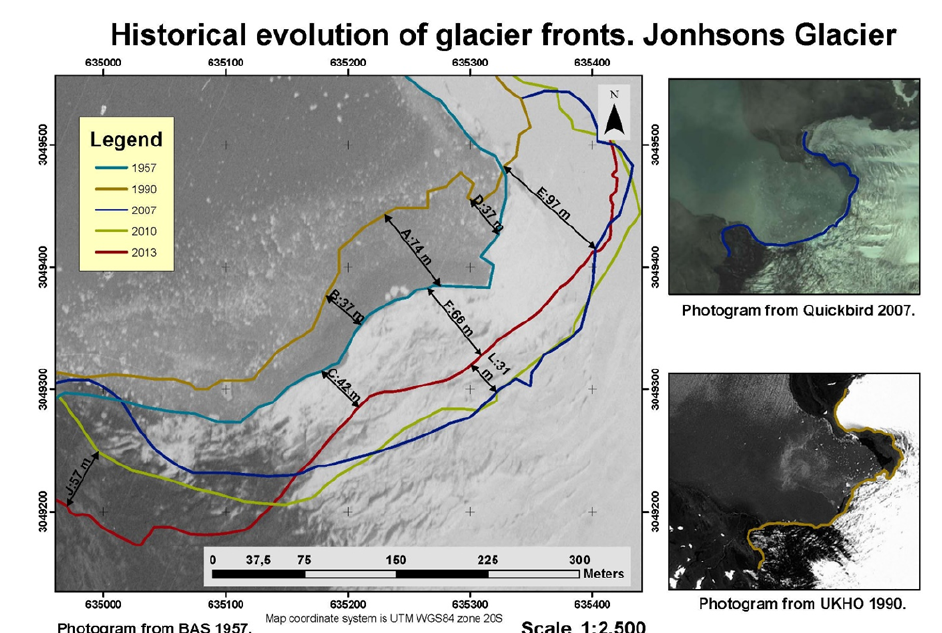
Figure 9. Calving front position changes of Johnsons Glacier. The oldest front position available corresponds to 1957 (in light blue) and the most recent to 2013 (in red). The base map corresponds to the BAS aerial photograph taken on 19 January 1957. The scale of the figure does not match with the numerical map scale